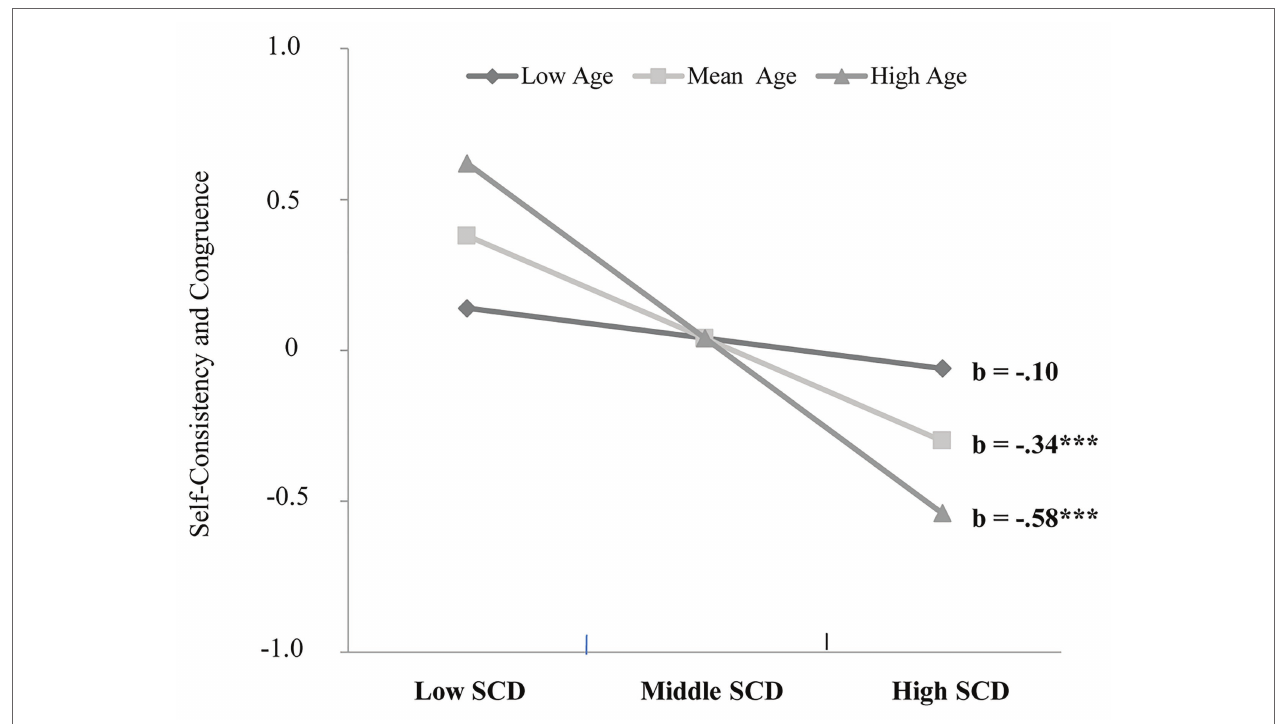
FIGURE 2 | The moderated effect of age on the relationship between self-concept differentiation and self-consistency and congruence.